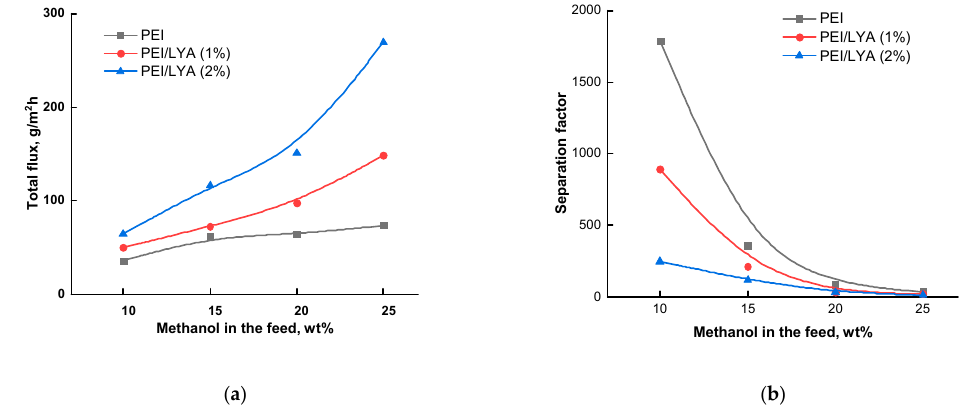
Figure 11. Dependence of ( a ) the total flux and ( b ) the separation factor on the methanol concentra ‐ tion in the feed for pervaporation of the methanol ‒ cyclohexane mixture using the PEI/LYA(0–2%) membranes at 20 °C.